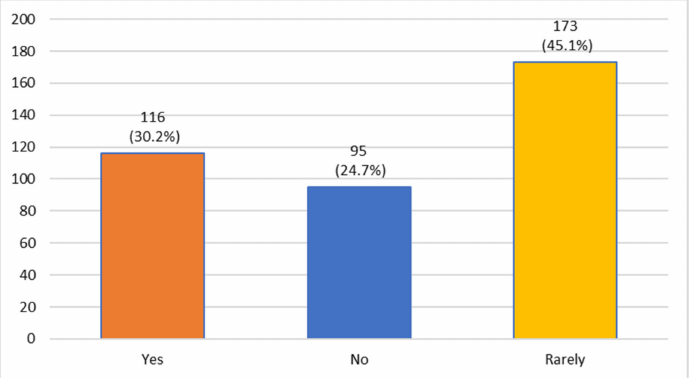
Figure 13. Distribution of children according to their interest in the consumption of biological products in